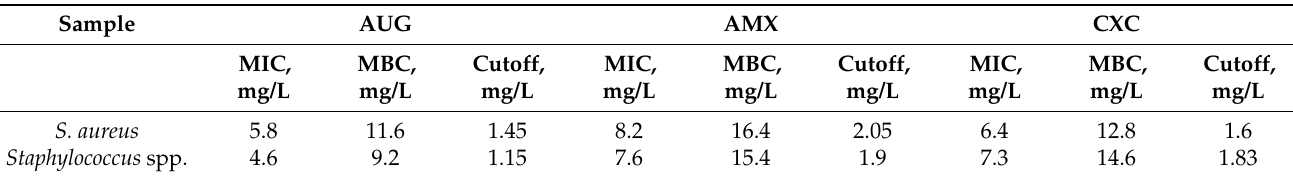
Table 3. Minimum inhibitory concentrations (MICs) and minimal bactericidal concentrations (MBCs) of S. aureus and Staphylococcus spp. to augmentin, amoxicillin, and cloxacillin antibiotics.